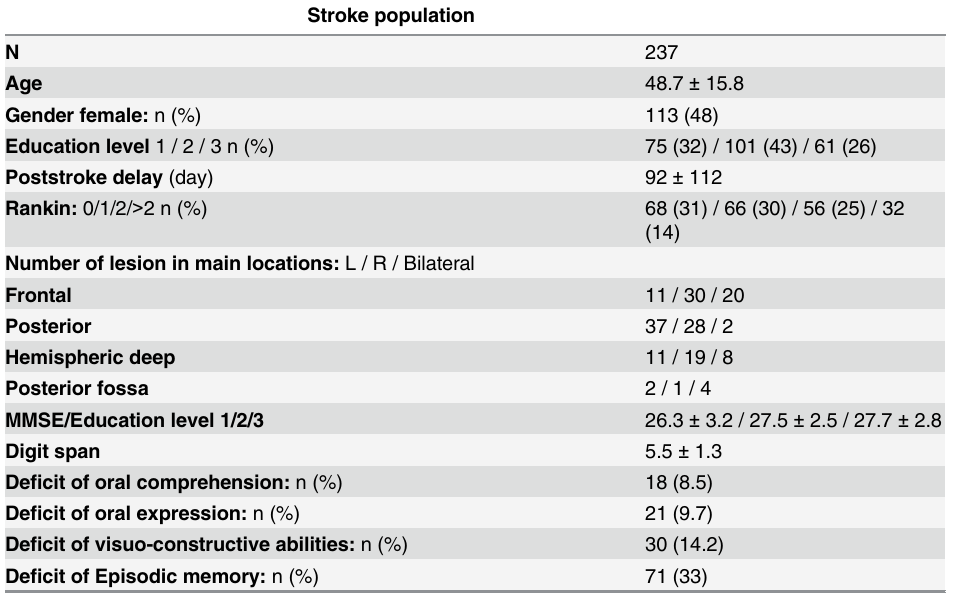
Table 1. Demographic, imaging and general neuropsychological characteristics of